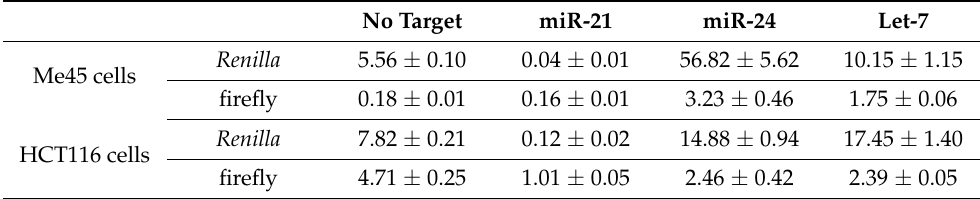
Table 1. Translation efficiency of miRNA-targeted Renilla or non-targeted co-transfected firefly transcripts [protein activity as a.u./mRNA molecule]